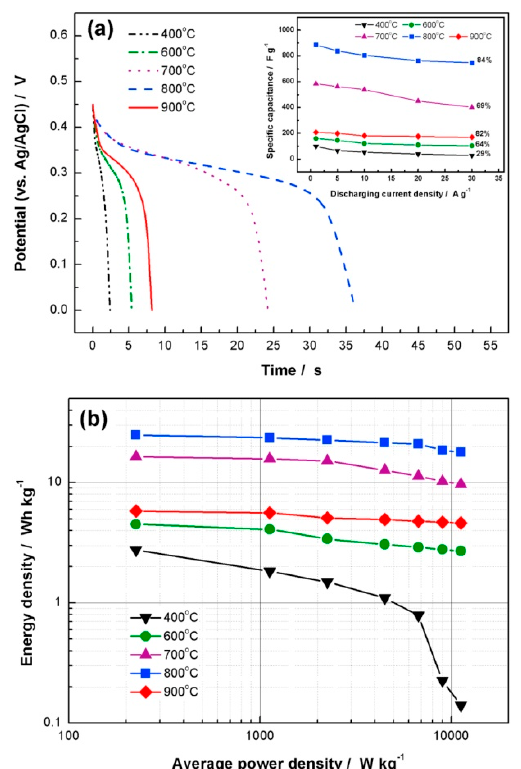
Figure 6. Electrochemical behaviors of working electrodes based on carbonized Ni-BDC for 3E setup using 1 M KOH electrolyte. ( a ) Discharge curves at 10 A g − 1 and influence of discharge current load on the specific capacitance (inset). ( b ) Ragone plots [99].